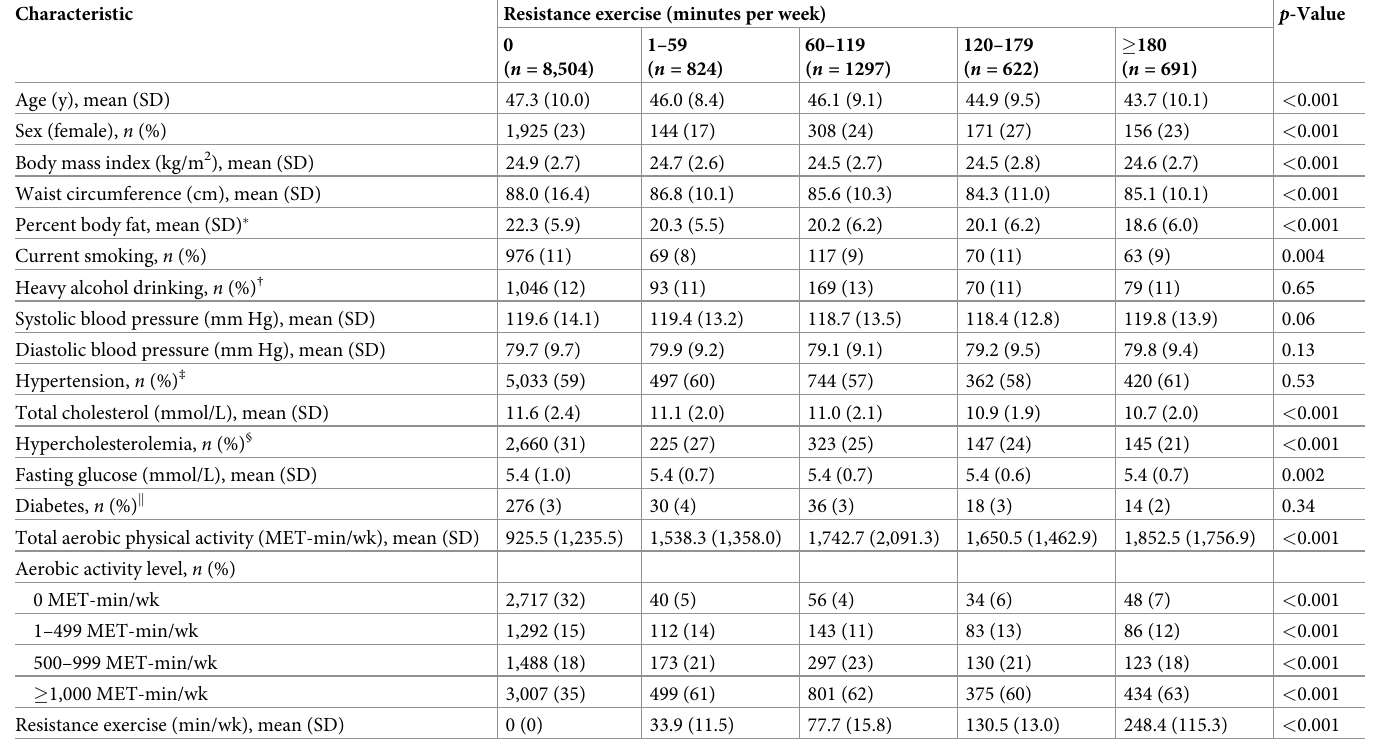
Table 1. Baseline characteristics of the 11,938 participants by weekly minutes of resistance